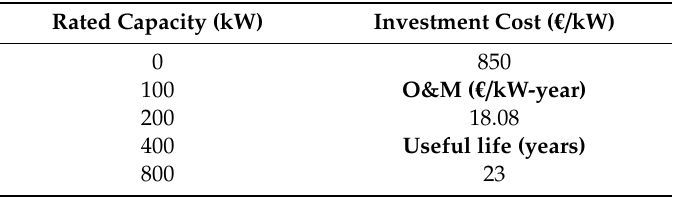
Table A1. PV systems data.